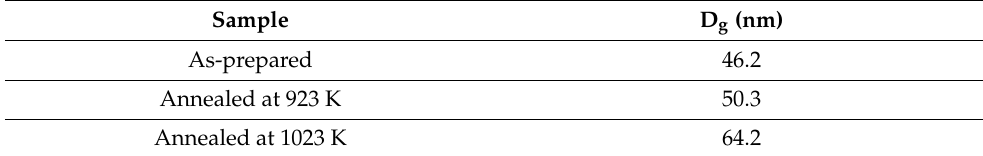
Table 1. Average grain size (nm) of annealed and as-prepared Co 2 MnSi glass-coated